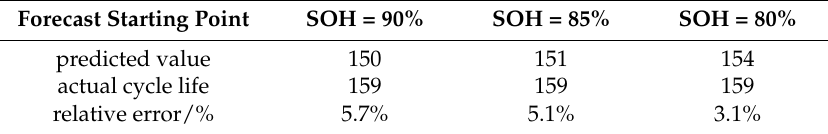
Table 2. Probability prediction results of No. 3 lithium battery cycle life.